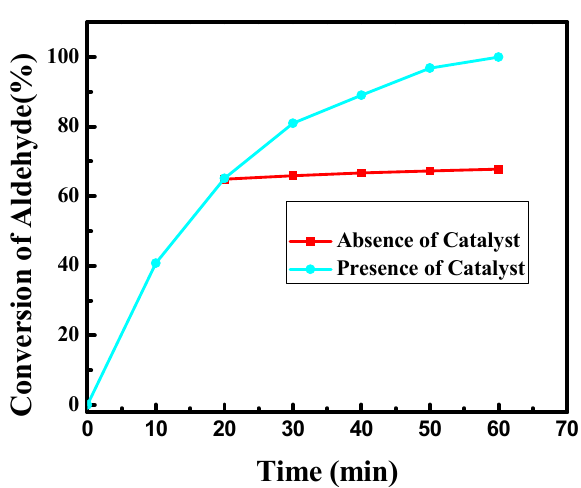
Figure 6. Plots For the hydrogenation of benzaldehyde into benzyl alcohol catalyzed by γ -Fe 2 O 3 @HAP-Pd. Reaction conditions: Benzaldehyde (1 mmol), γ -Fe 2 O 3 @HAP-Pd catalyst (10 mg), H 2 O (10 mL), 10 bar H 2 , 25 °C, and 1 h.